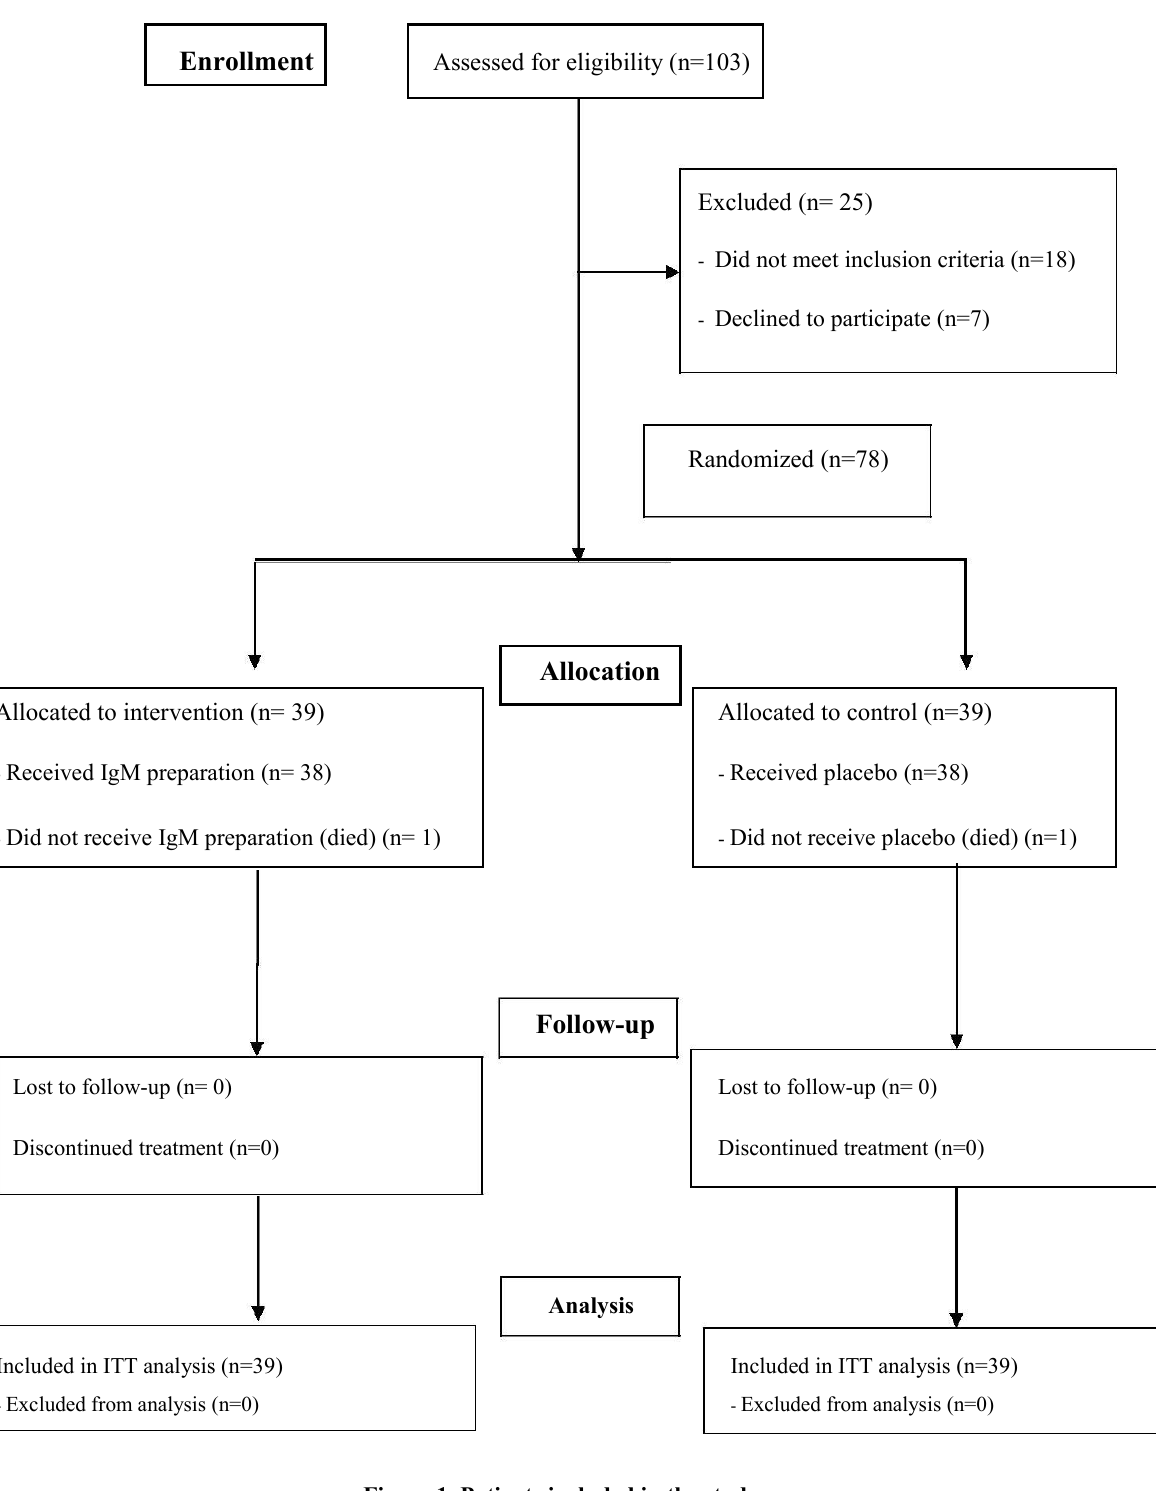
Figure 1. Patients included in the